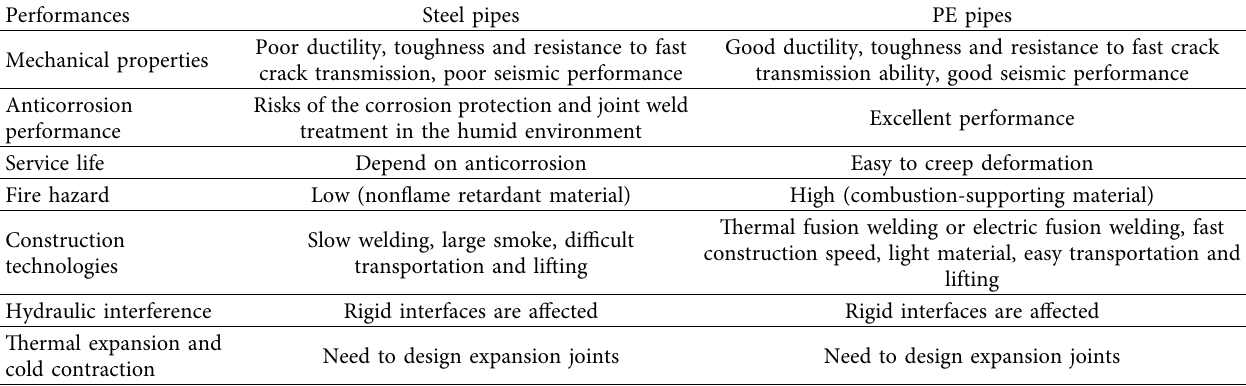
Table 1: Comparisons of main performances between steel and PE pipes [45,